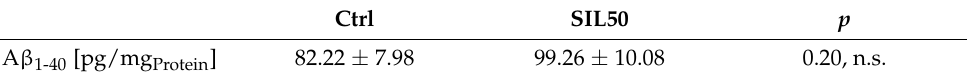
Table 2. A β 1-40 levels in PC12APP sw cells treated with 50 µ M SIL. A β was determined via Homo- geneous Time-Resolved Fluorescence (HTRF). Data are adjusted to protein content of the samples. Data are displayed as mean ± SEM. n = 10. Statistical significance was tested via Student’s t -test ( n.s. p >